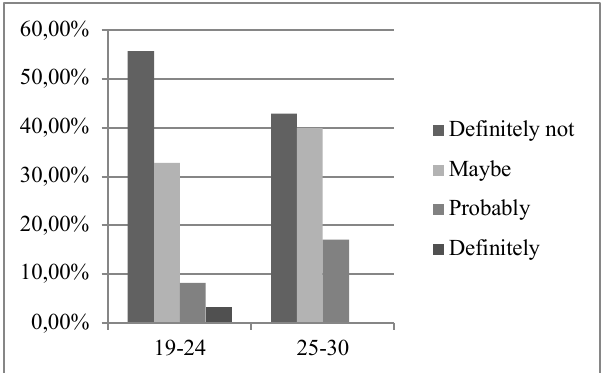
Fig. 1. Cross-tabulation analysis of questions B3 and